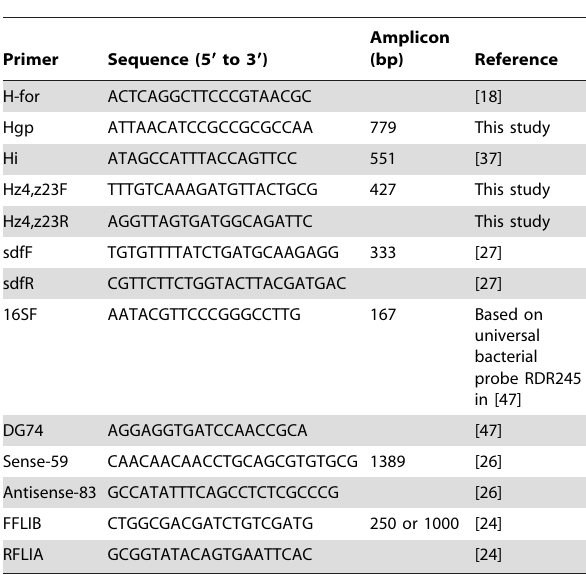
Table 2. Primers used in this